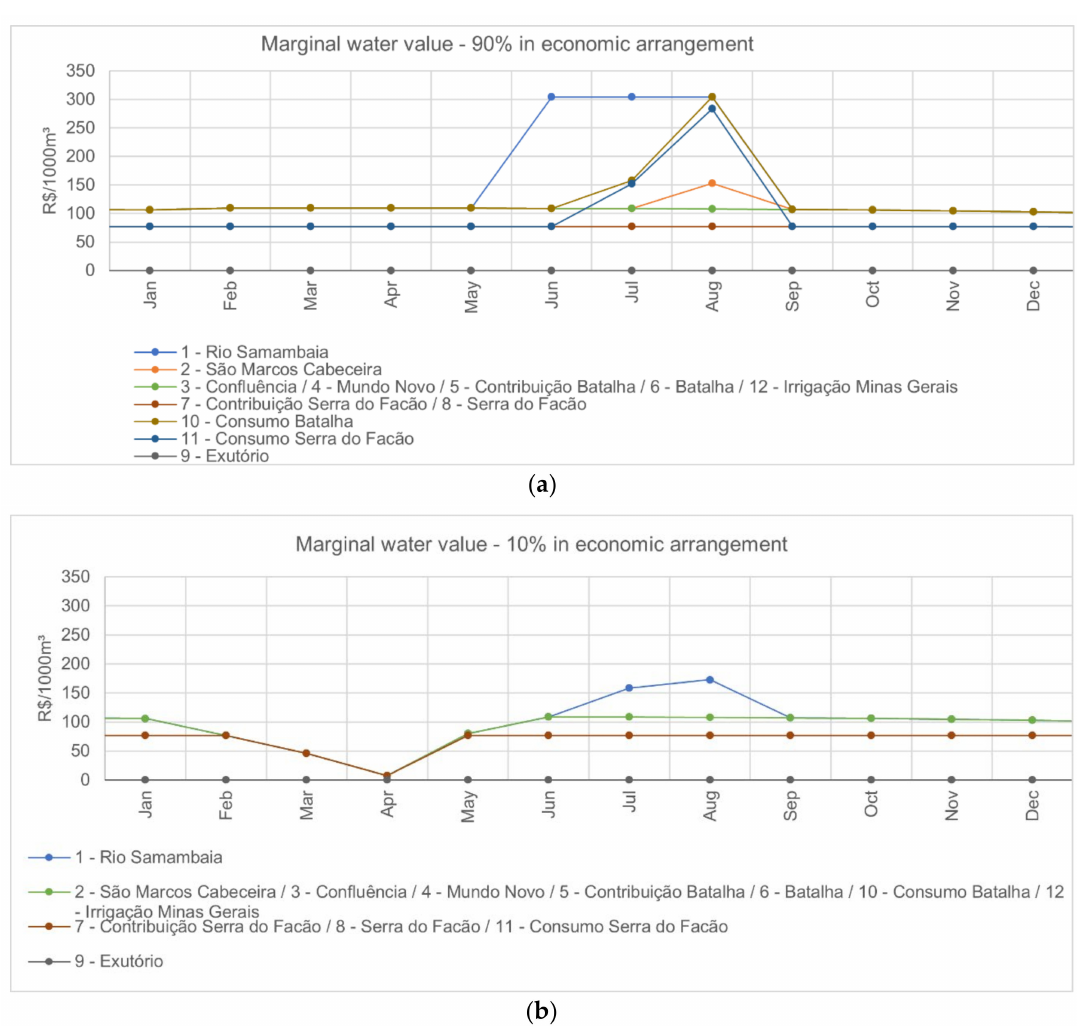
Figure 8. Marginal value of water in the nodes per month, economic arrangement, with 90% ( a ) and 10% ( b ) exceedance prob-